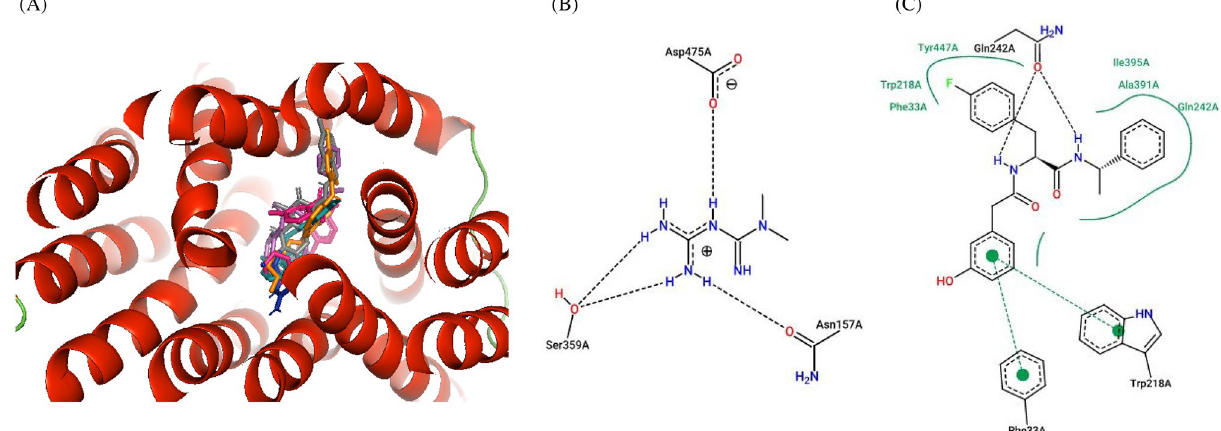
Figure 9. Ligand overlay for haplotype 4 SLC22A2 protein. ( A ) Image was generated using Pymol with the first line anti-diabetic drug, Metformin, shown in blue. The four top binding ligands Isavuconazole, Dolutegravir, Glibenclamide, and Vandetanib are shown in deep teal, grey, hot-pink, and orange respectively. The 5RE inhibitor is indicated in magenta. ( B,C ) 2D PoseView illustration, showing interacting residues for Metformin and the 5RE inhibitor respectively—dotted black lines denote hydrogen bonds, solid green lines denote hydrophobic interactions and dotted green lines denote π stacking &/or aromatic interactions.